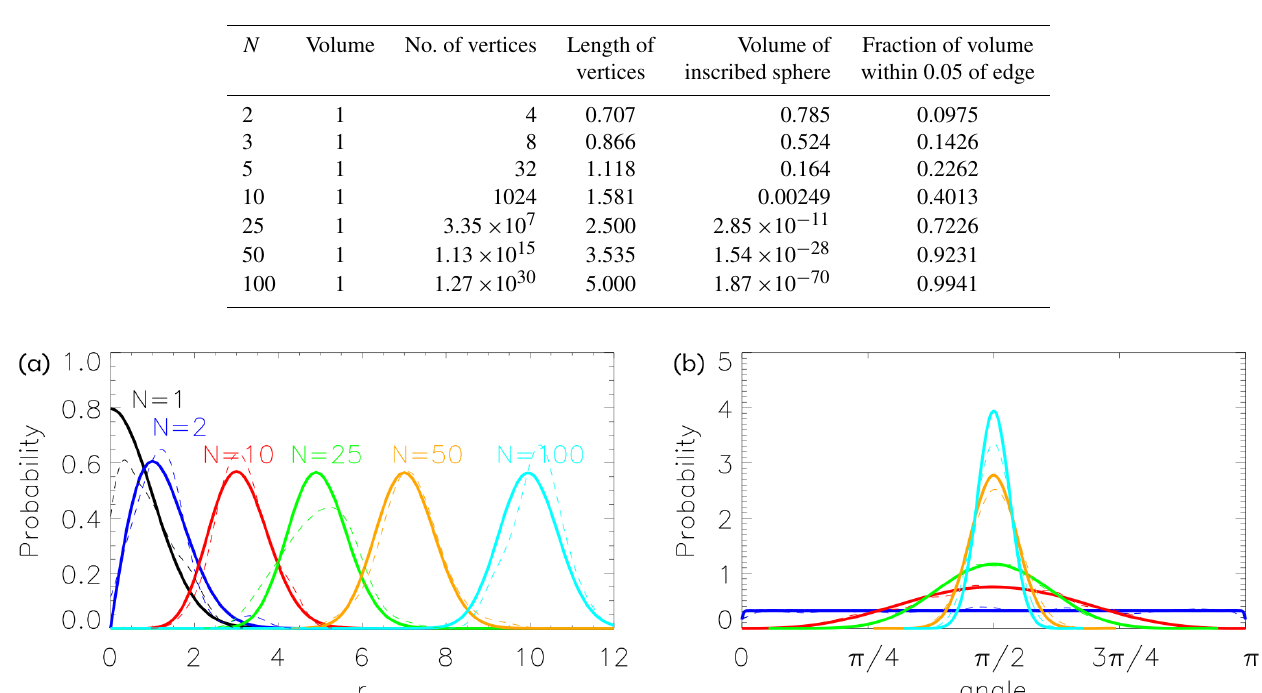
Table 1. Results for a unit cube in N dimensions. The vertices of a unit cube [− 1 / 2 , 1 / 2 ] N are [± 1 / 2 , ± 1 / 2 ,... ± 1 / 2 ] . The number of √ N/ 2. The fraction of volume within (cid:15) of the edge is 1 − ( 1 − (cid:15)) N . The volume of the inscribed vertices is 2 N and the length of the vertices sphere is π N/ 2 (d/ 4 ) N /(cid:48)(N/ 2 + 1 ) with d = 1.